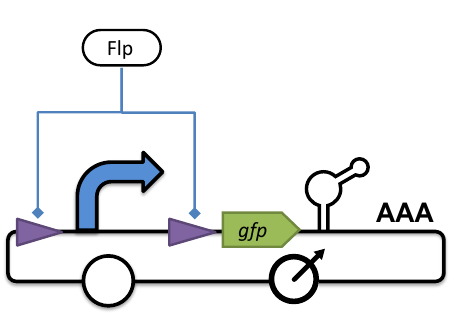
Figure 38: Promoter regulating the expression of GFP, which is also regulated by an aptamer between it and the poly-A tail of the transcript. The promoter can be cut out by a pair of recombinase target sites, which are acted on by the Flp protein. The whole construct is stored in a circular plasmid with an origin of replication and also an origin of transfer.